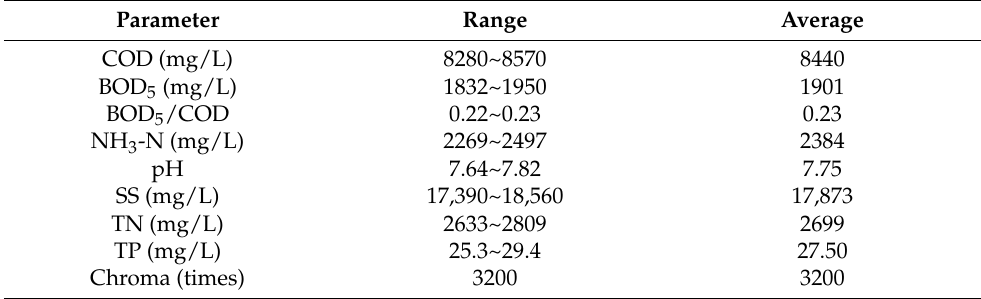
Table 2. Landfill leachate characteristics.